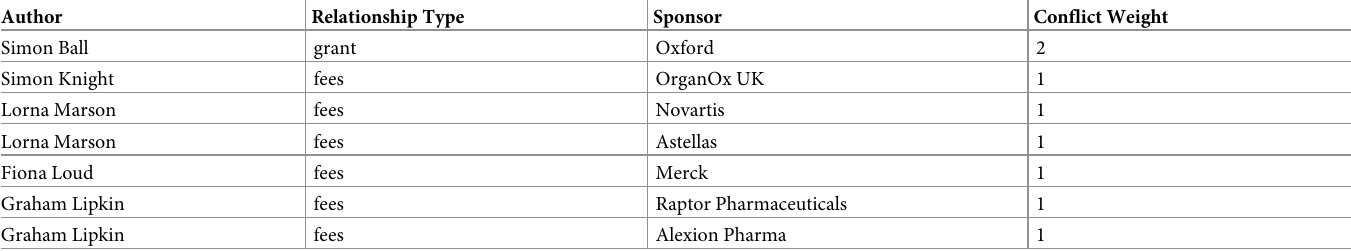
Table 1. Fully-parsed disclosure statement for “defining priorities for future research: Results of the UK kidney transplant priority setting partnership” (PMID: